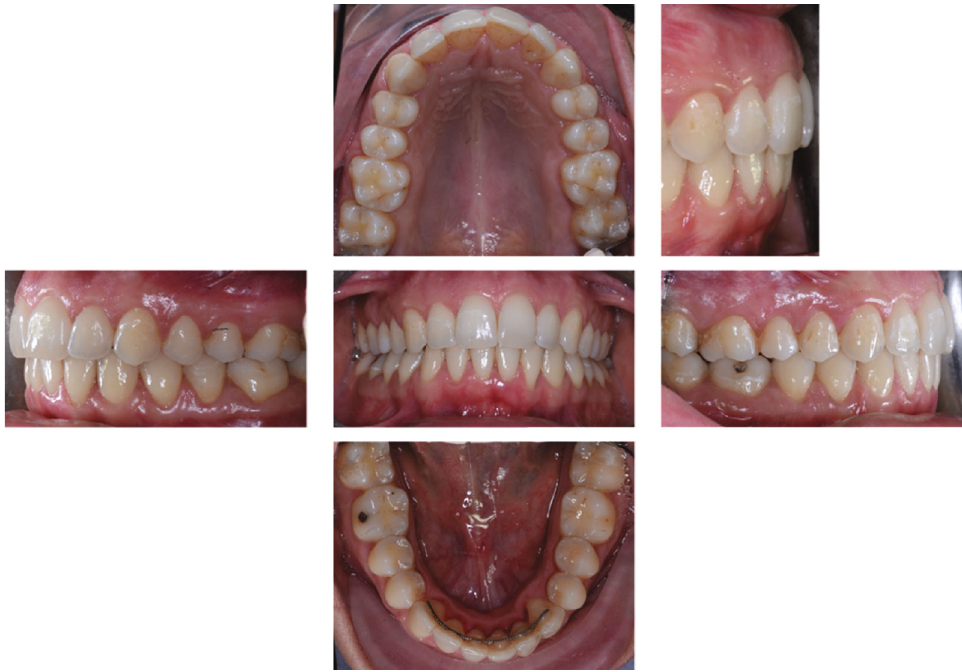
Figure 22: 20-year follow-up intraoral